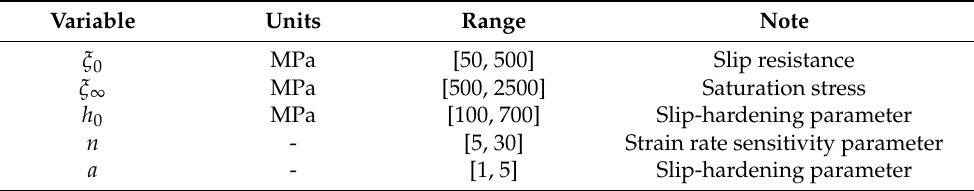
Table 5. Ranges of the adjustable parameters for the phenomenological CP model. Table 4. Definitive constitutive parameters for the phenomenological CP model.